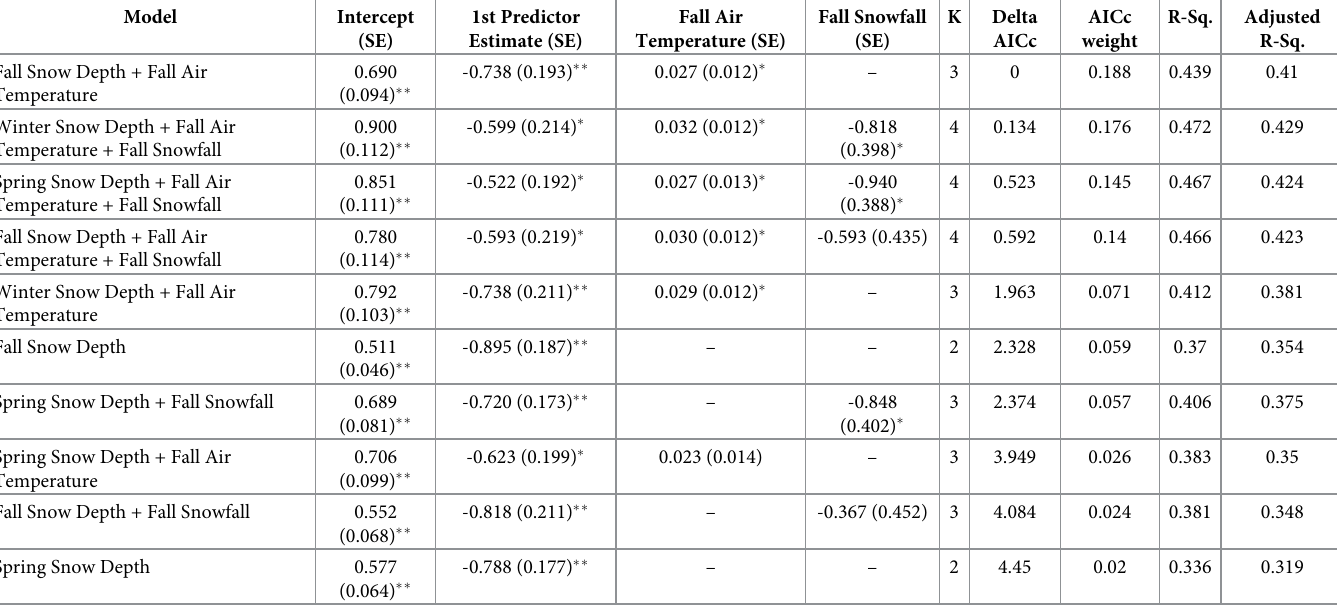
Table 1. Top 10 models as ranked by second order Akaike Information Criterion